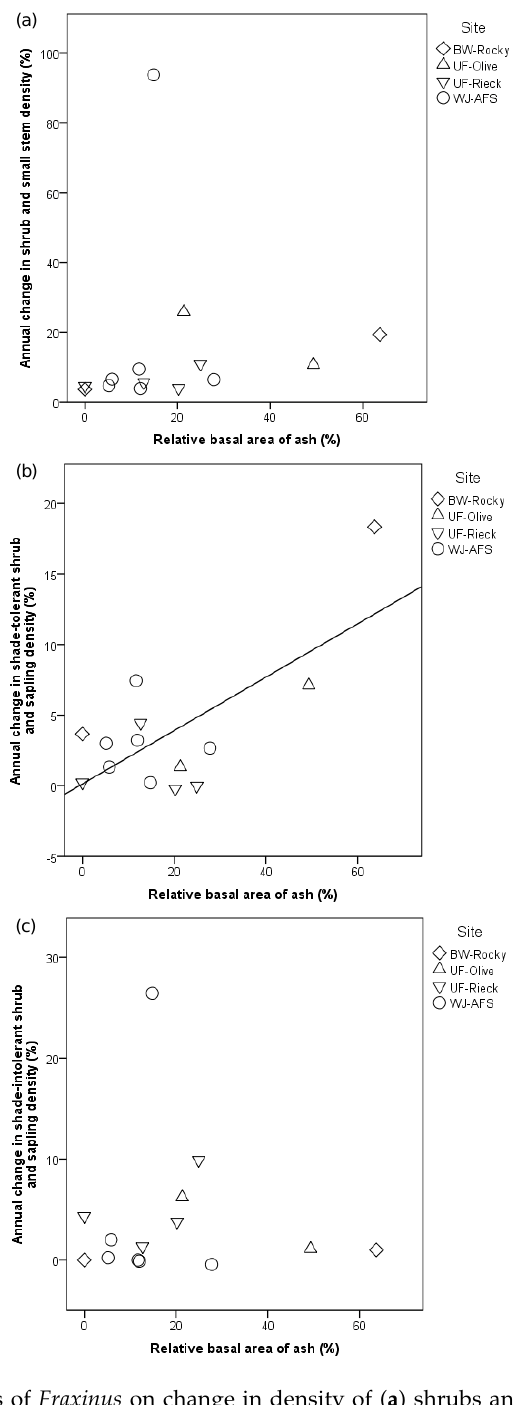
Figure 5. Effects of loss of Fraxinus on change in density of ( a ) shrubs and saplings of all species ( r 2 = 0.01, p = 0.764), ( b ) shade-tolerant species ( r 2 = 0.50, p = 0.005), and ( c ) shade-intolerant species ( r 2 = 0.003, p = 0.853).